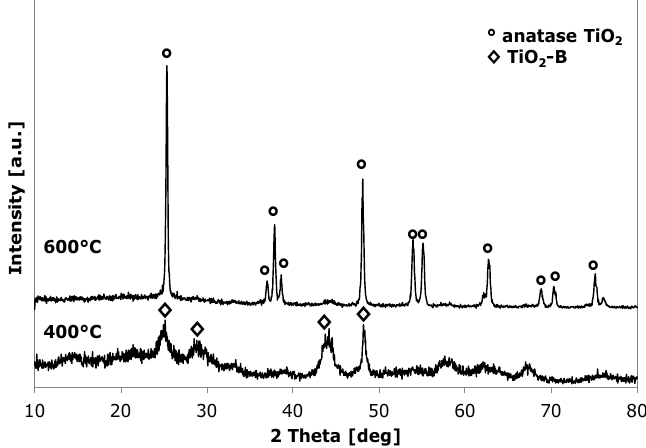
nanowires calcined at 400 and 2